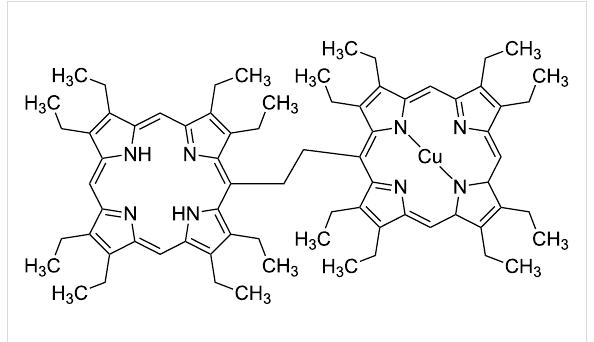
Figure 2: Chemical structure of the monometallated copper complex of the ethano-bridged bis-porphyrin derivative, Cu,H 2 -Por 2